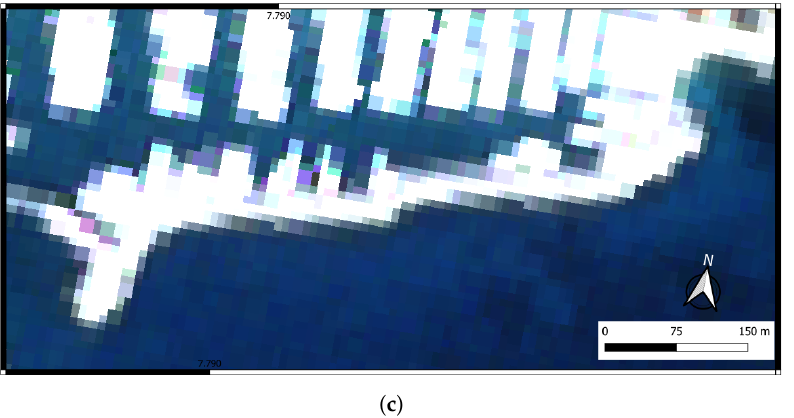
Figure 4. Portosole marina: ( a ) UAV-, ( b ) aircraft-, and ( c ) S-2-derived orthophotos. The different resolutions (0.02 m, 0.2 m and 10 m) of the orthophotos can be